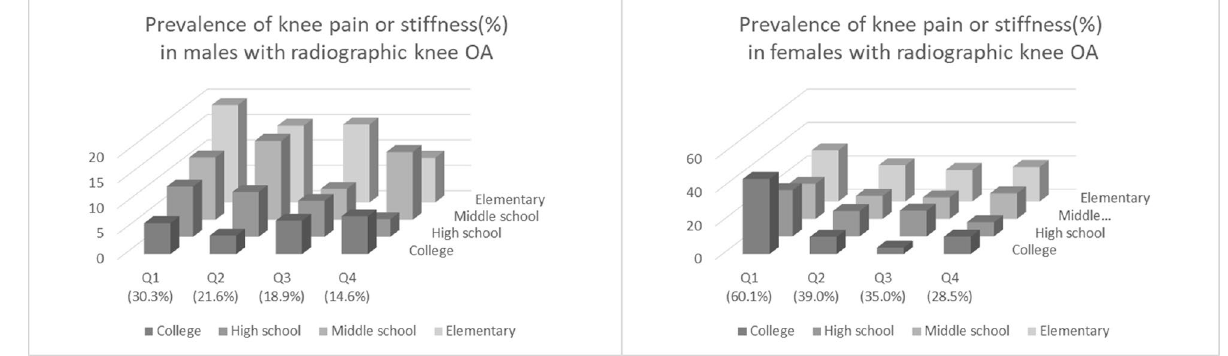
Figure 2. The prevalence of knee symptoms among those with radiographic knee osteoarthritis(OA) according to income level and education status.